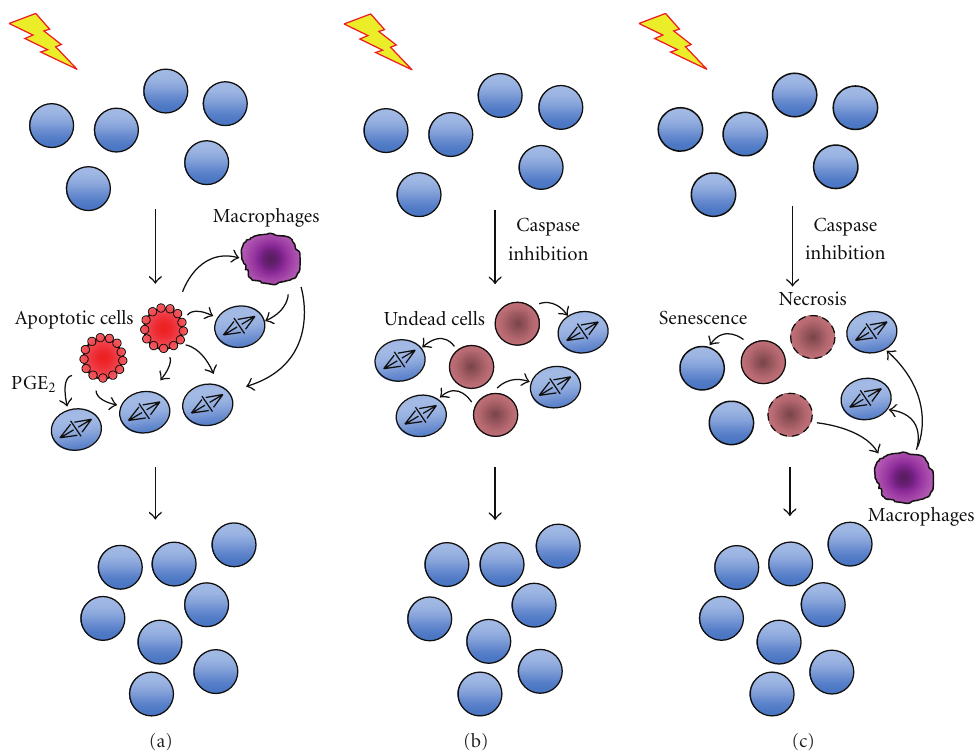
Figure 2: Radio- or chemotherapy induces cancer cell apoptosis generating proliferation signals that drive the rapid proliferation of surviving cancer cells which repopulate the tumour by generating signals that act directly on stem/progenitor cells or by recruiting macrophages (a). The role of PUMA in compensatory proliferation has led to the suggestion that blocking caspase-mediated cleavage of iPLA 2 with small molecule caspase inhibitors may improve patient outcomes by preventing this compensatory proliferation. However the general applicability of this model is uncertain for several reasons. Firstly, in Drosophila development blocking apoptosis in some circumstances produces undead cells whose persistent signalling increases compensatory proliferation (b). Secondly, while caspase inhibitors block apoptosis, the irradiated or drug-treated cells may still die by nonapoptotic processes or become senescent, which may induce compensatory proliferation as well